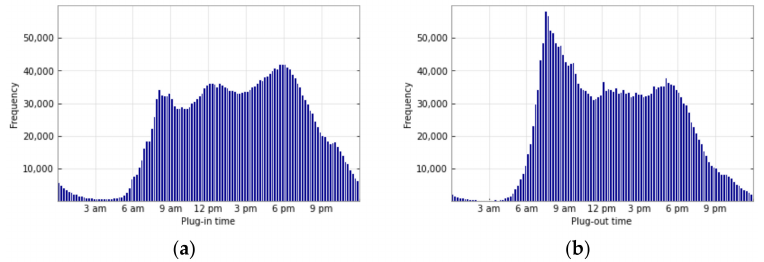
Figure 1. ( a ) Distribution of plug-in times over all Germany; ( b ) Distribution of plug-out times over all Germany.